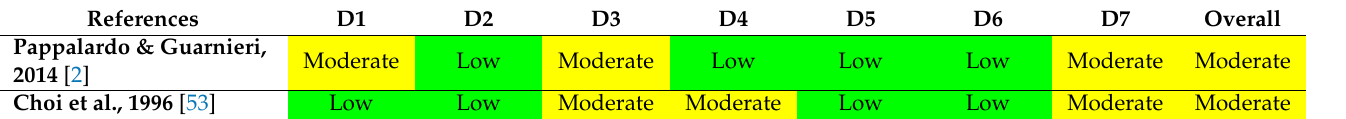
Table 5. Risk of bias assessment: reviewers’ judgments about each risk of bias item for each in- cluded RCT.